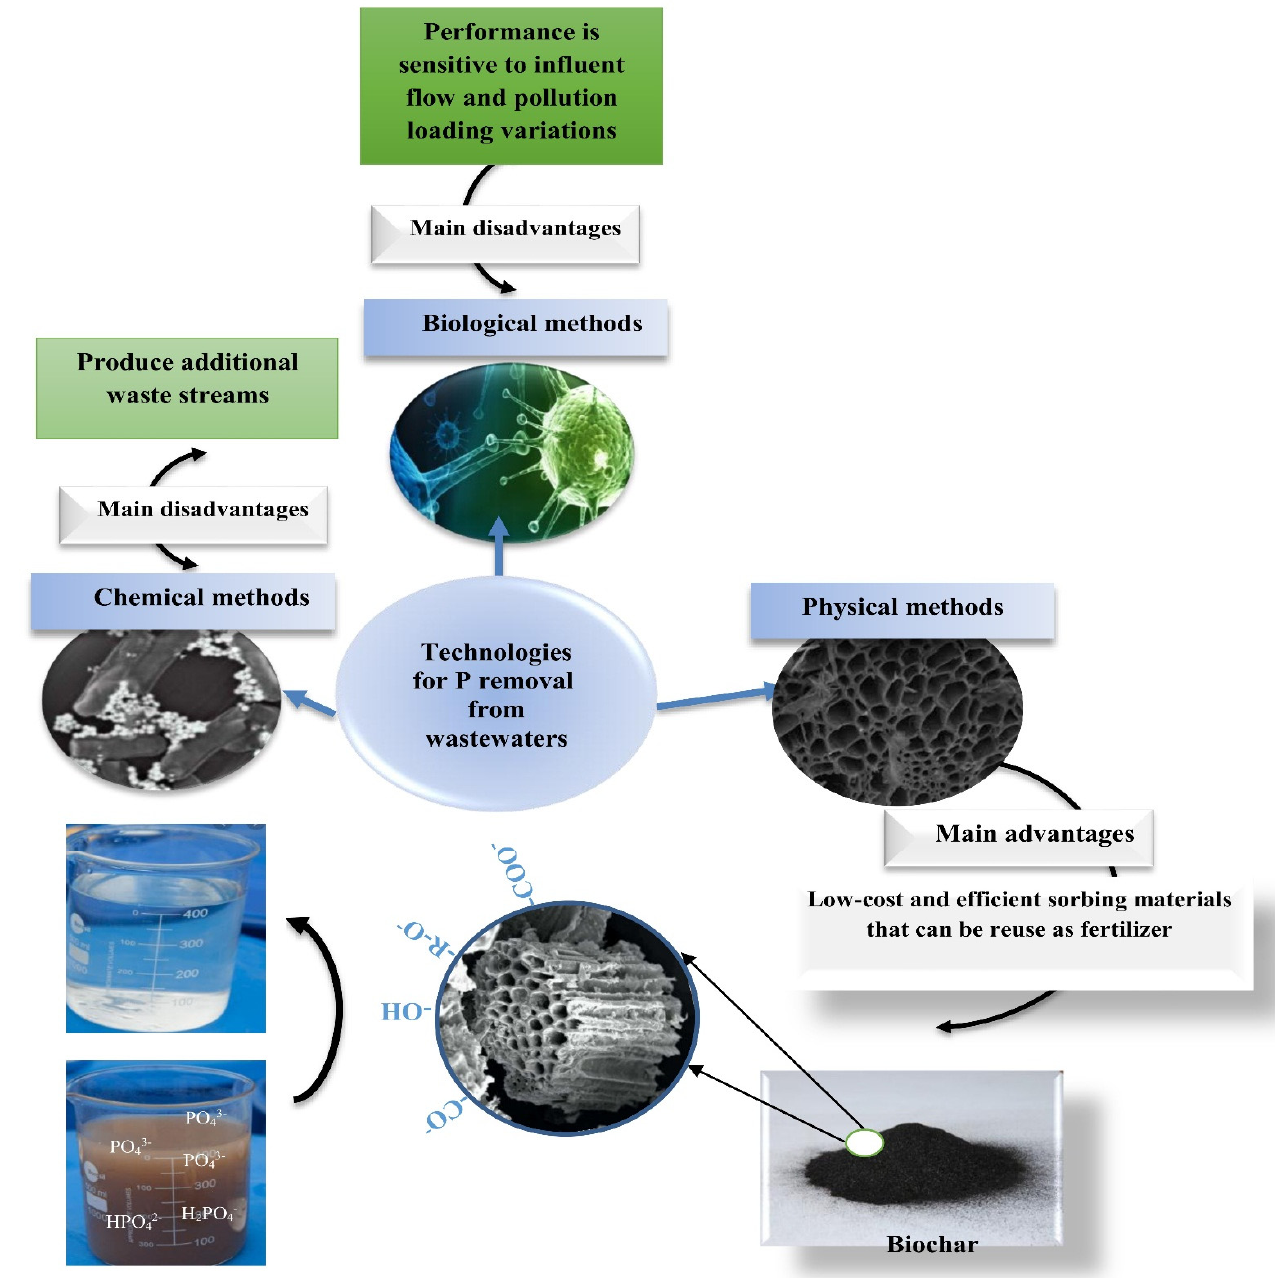
Figure 2. Advantages of biochar application over other phosphorus removal methods.